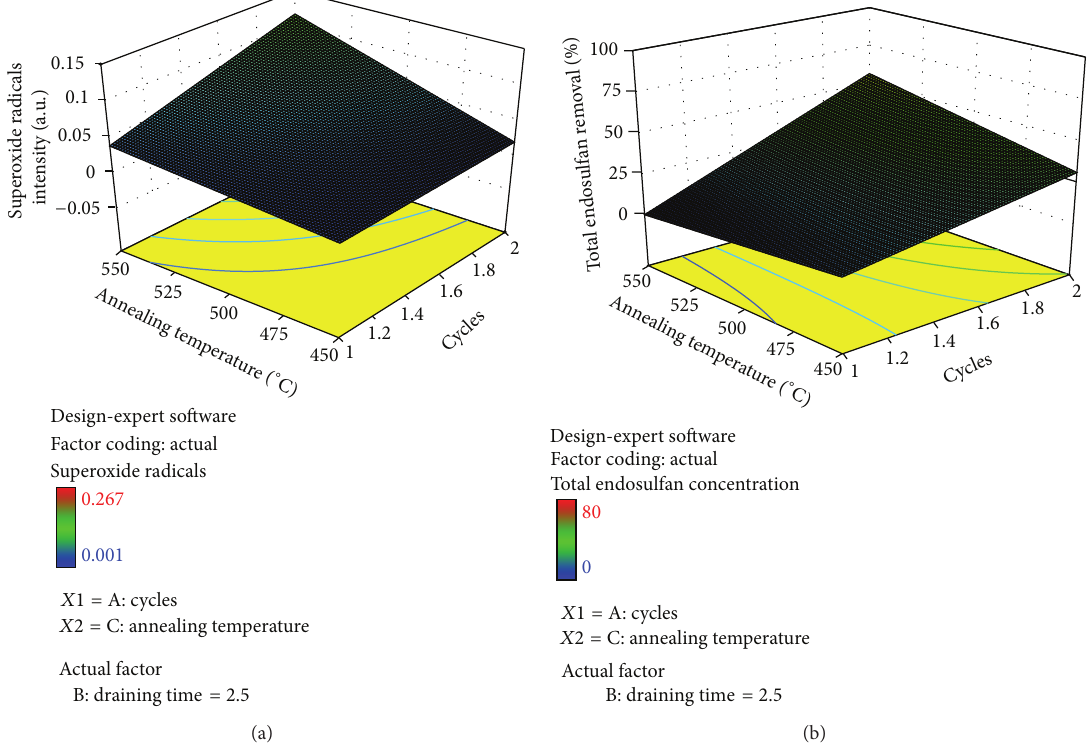
Figure 6: Effect of high level of draining/annealing cycles and annealing temperature for (a) superoxide radical generation; and (b) total endosulfan degradation at 30 minutes of the photoactivity assay.